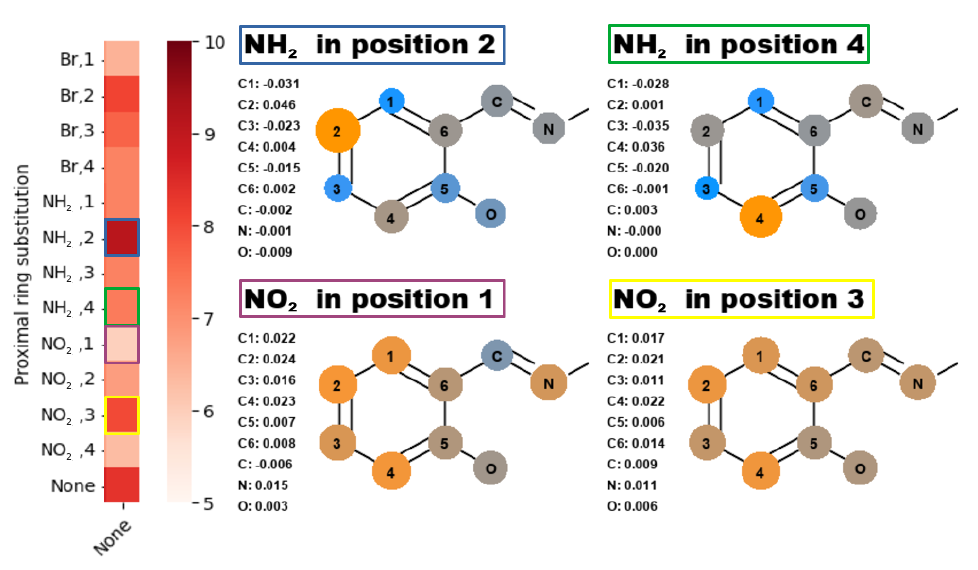
Figure 5. Differences of charge distribution for the selected proximal substitution patterns compared to the non-substituted structure, and related to their respective fields on the activation energy heatmap from Figure